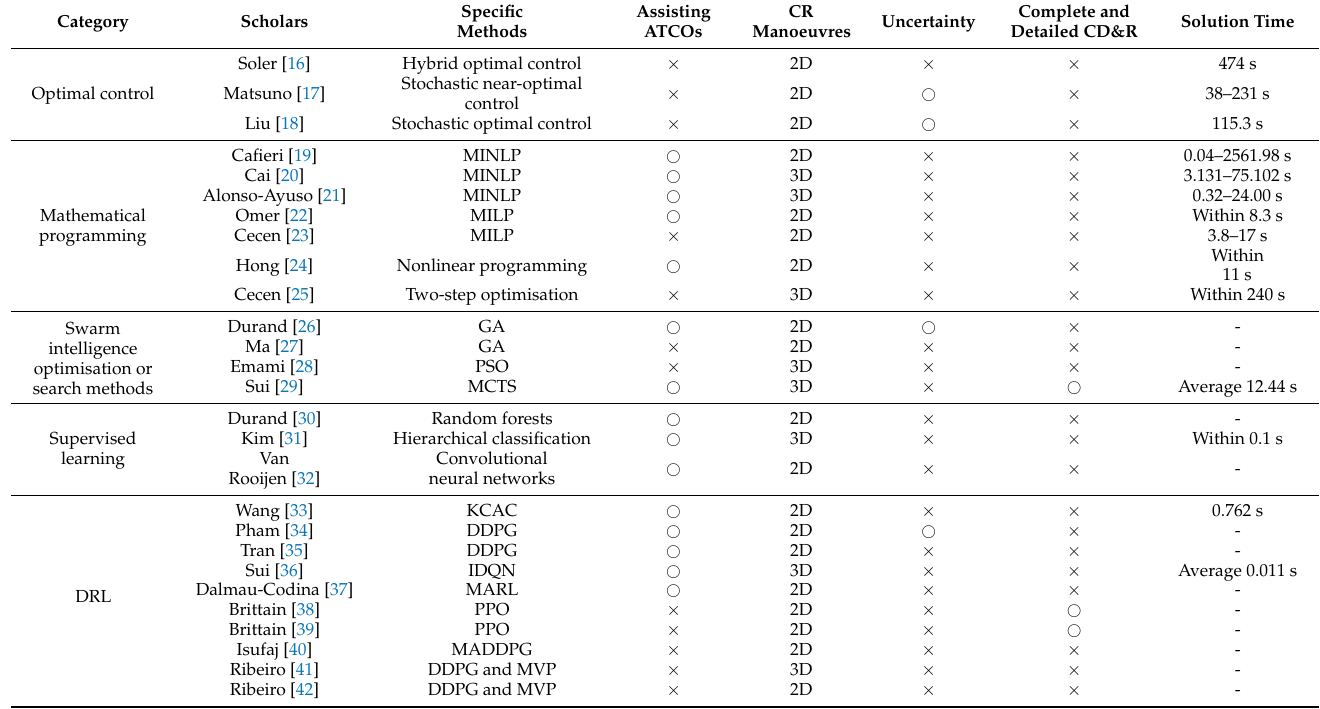
Table 1. Features of conflict resolution